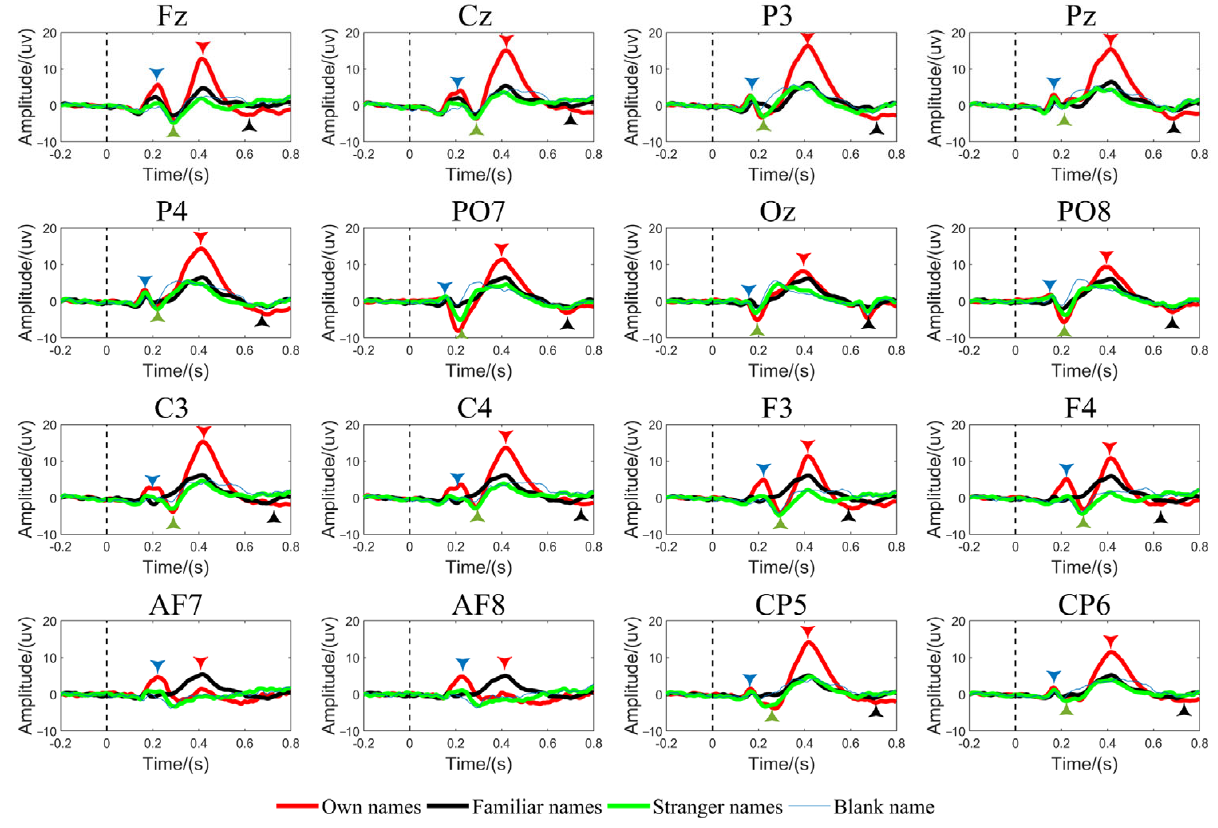
Figure 2. EEG components of self-information